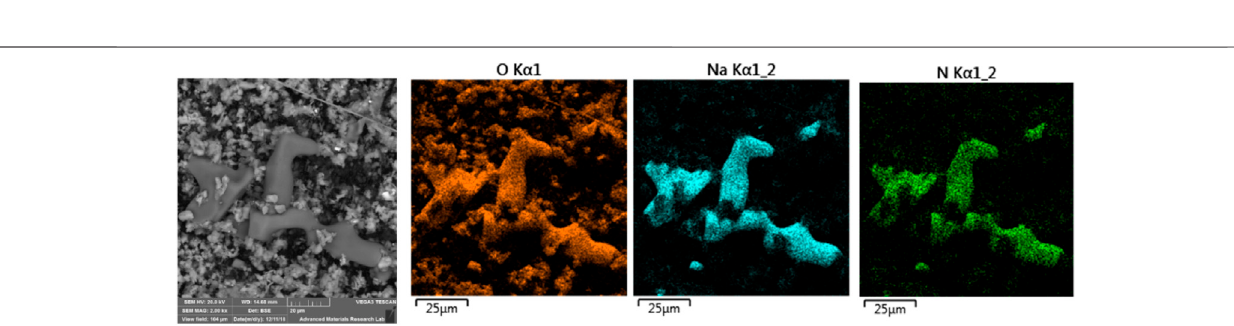
FIGURE 8 | XRD pattern for PM 10 sample #50, sampled on July 24, 2018, a clear day with PM mass concentration of 125 μ g/m 3 .